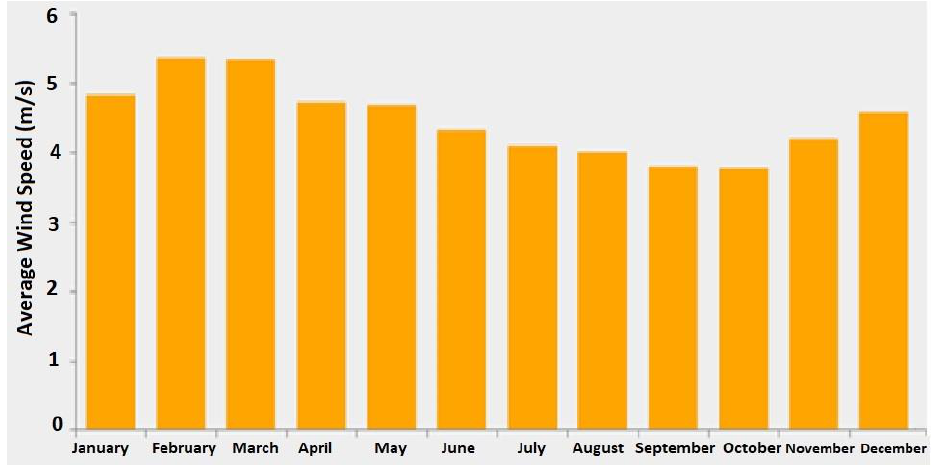
Figure 3. Average wind speed at Yas Island .